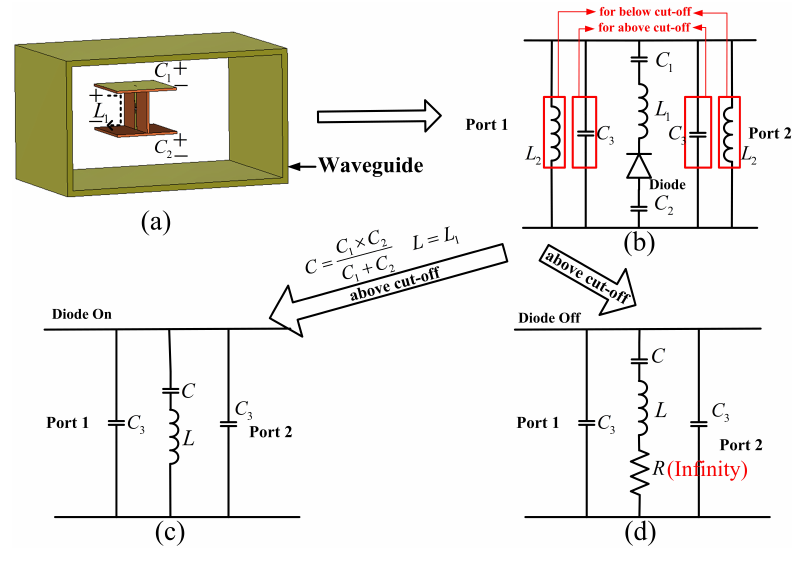
Figure 2. ESF in waveguide and equivalent